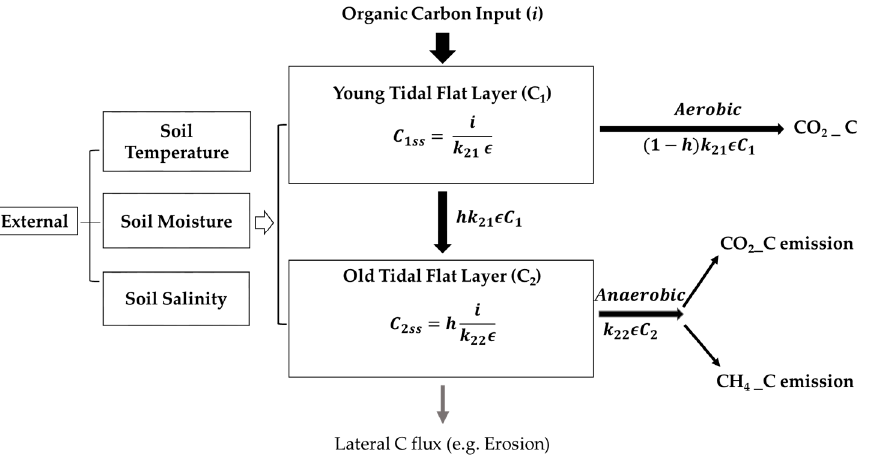
Figure 1. Concept model of GHG emissions from tidal flats. Flux equations are positioned close to their respective arrows, and equations describing steady-state conditions are inside the boxes (i.e., when the pools are constant and the inputs and outputs balance out). Where, C 1ss = total organic carbon (kgC m − 2 ) of YL in a steady state, C 2ss = total amount of organic carbon in OL in the steady-state (kgC m − 2 ).